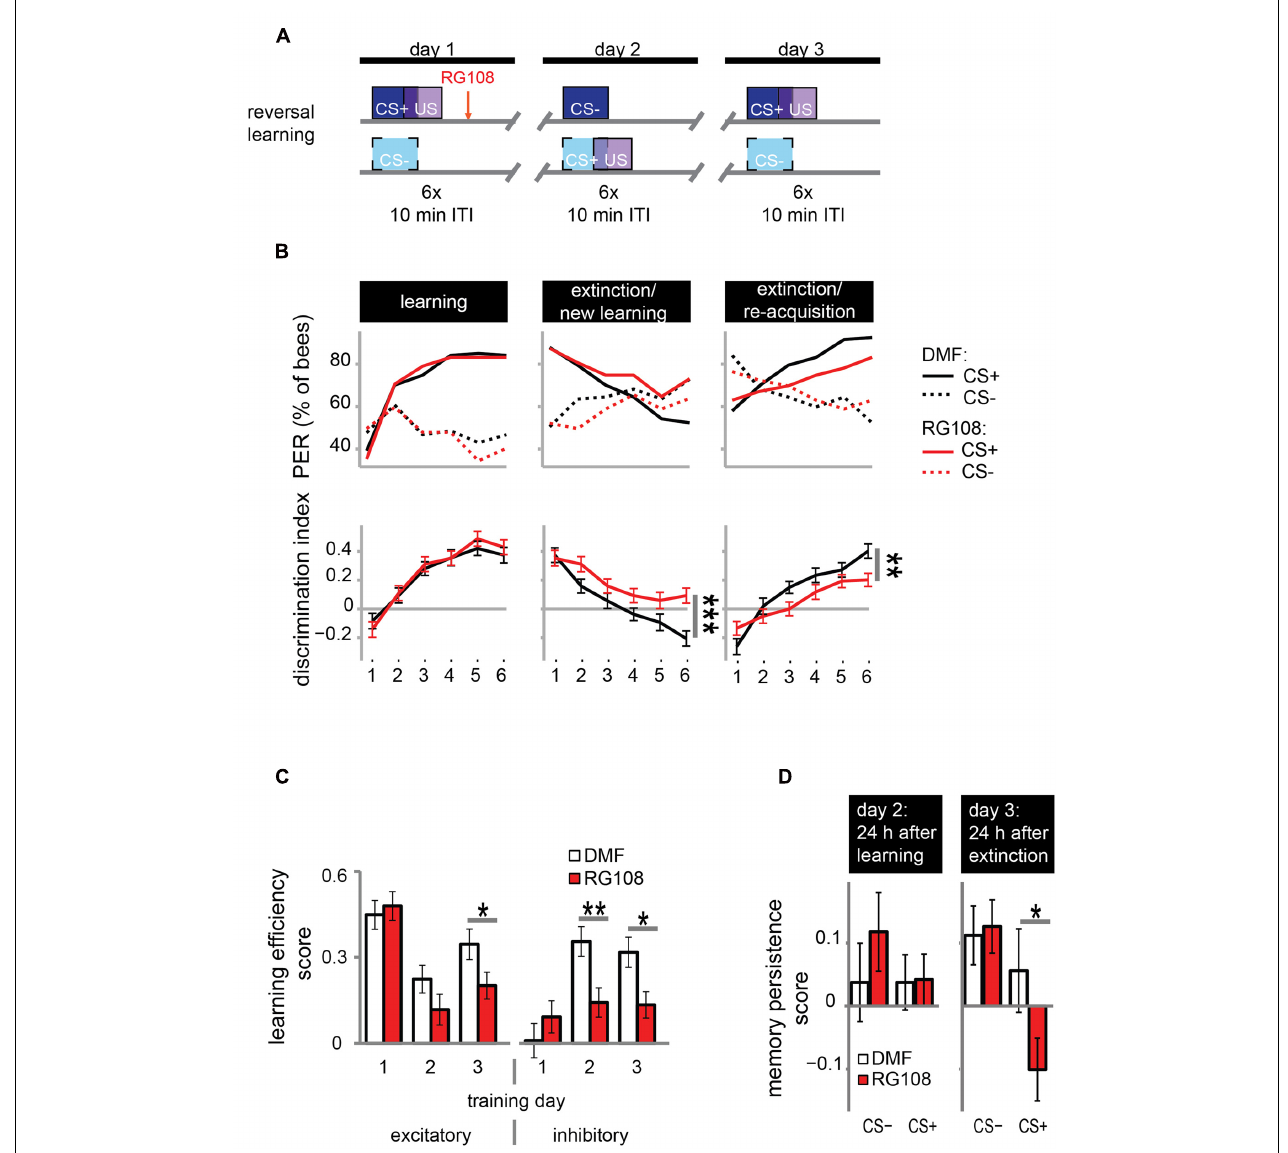
FIGURE 3 | DNA methyltransferases promote the relearning of previously learned stimuli. (A) Bees were trained with a reversal training paradigm. (B) Solvent treated control bees responded correctly at the end of each training. RG108 treated bees, however, did not reverse the odor contingencies on day 2 (extinction/new learning) and performed significantly worse than control bees [ n (DMF) = 107, n (RG108) = 119]. On day 3 (extinction/re-acquisition) they learned the reversal but did so significantly slower than control bees. (C) Learning efficiency scores (bees’ last minus its first training trial response; 0 = same response, 1 = successful learning, − 1 = opposite response) were calculated for the excitatory and inhibitory components in each training. The excitatory component was impaired by RG108 treatment only on training day 3. The inhibitory component was impaired on training days 2 and 3. (D) Memory persistence scores (difference in a bees’ response between the last training trial and the first one 24 h later; 0 = same response, 1 = increase, − 1 = decrease) were calculated for each period between trainings. RG108 treatment did not change the response to the CS + or the CS − over the 24 h initial learning. During the second 24 h, however, RG108 treated bees changed their response to the unrewarded odor, but control bees did not. ∗ p -value < 0.05; ∗∗ p -value < 0.01; ∗∗∗ p -value < 0.001.